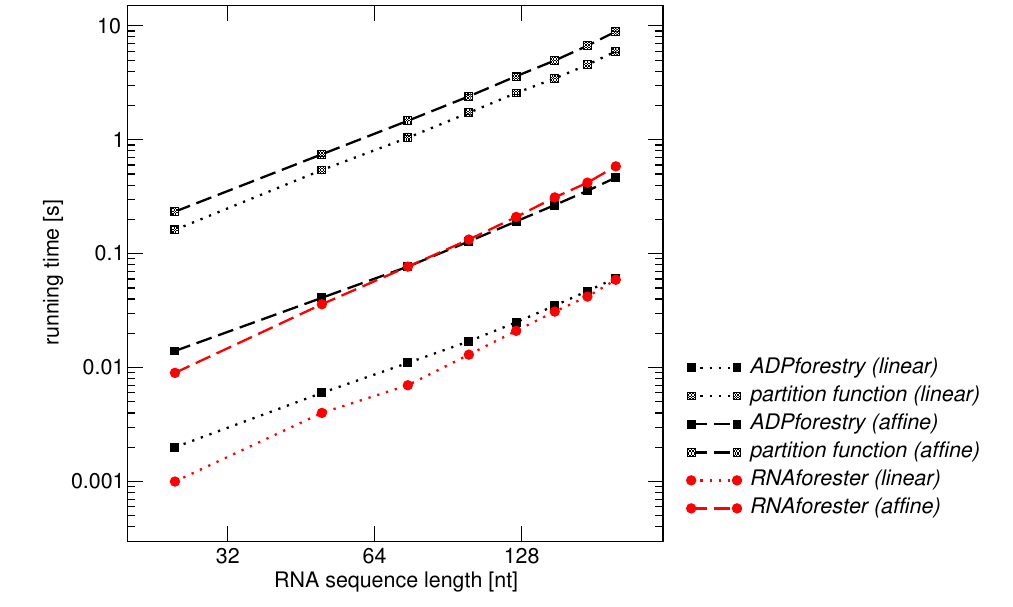
Figure 7. Comparison of the running times (in seconds) of RNAforester and algebraic dynamic programming (ADP)forestry measured as an average over 50 instances of random RNA secondary structures of different lengths using linear and affine gap costs, respectively. The benchmarks were performed on an Intel(R) Core(TM) i5-4570 machine with 32 Gb memory. RNAforester does not implement an Inside-Outside (partition function) version of tree